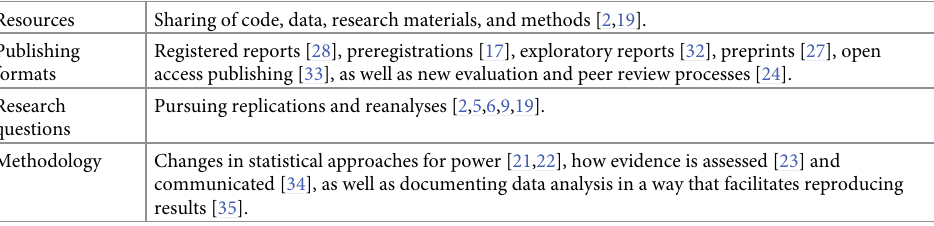
Table 1. Open science practices. Some methods introduced or suggested by the open science community to improve scientific practices.